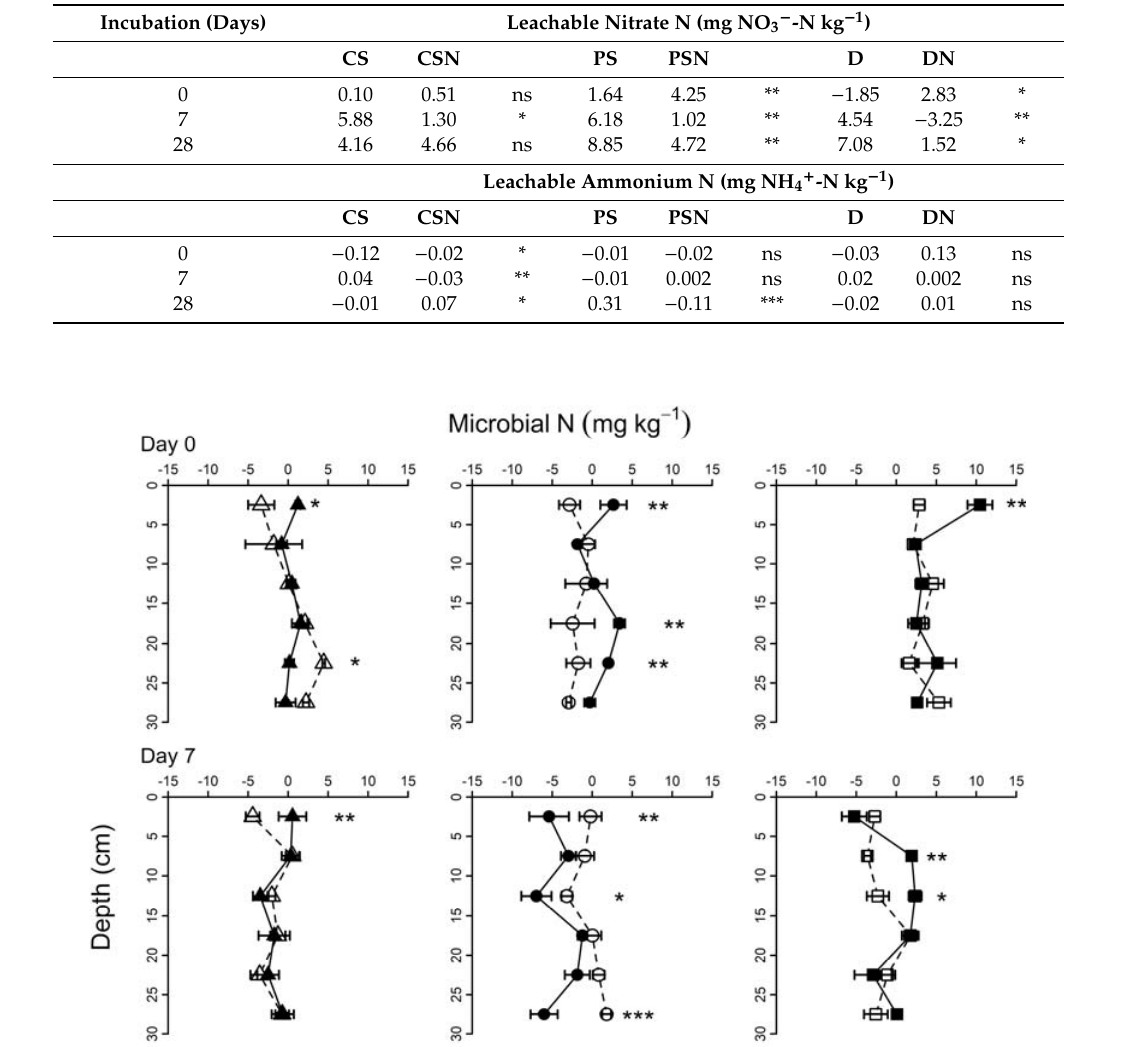
); pig slurry plus (cid:35)